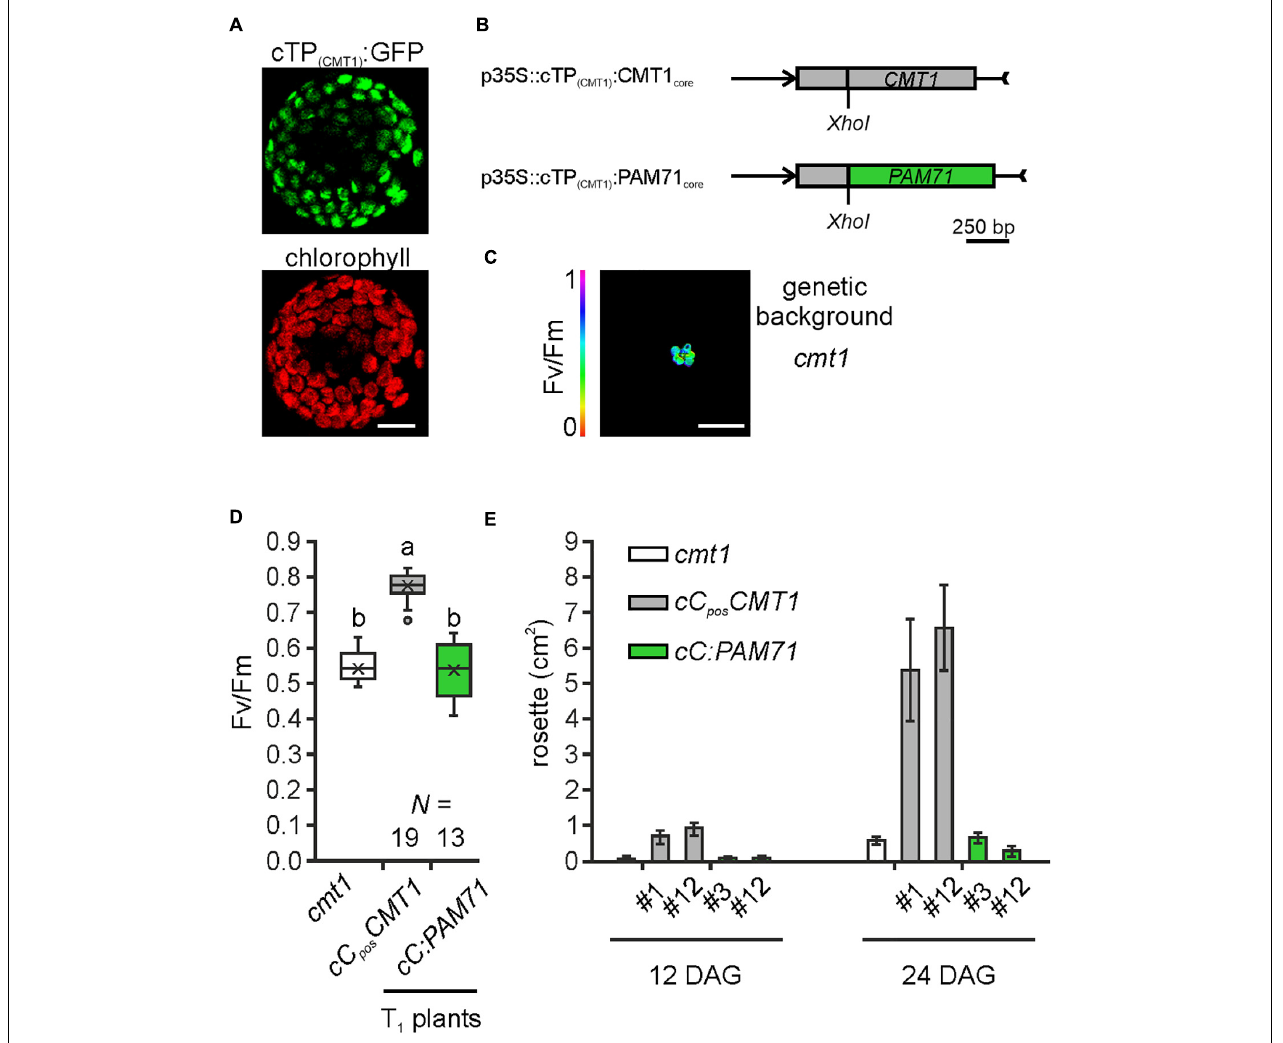
FIGURE 6 | Experimental setup for gene replacement assay and analysis of individual transgenic lines in the cmt1 genetic background. (A) Verification of the N-terminal CMT1 sequence as a chloroplast-targeting peptide. Nicotiana benthamiana leaves were infiltrated with the Agrobacterium strain containing p35S:cTP ( CMT 1 ) :GFP; protoplasts were isolated after 48 h and analyzed by confocal microscopy. Scale bar = 12.5 µ m. (B) Schematic depiction of the chimeric constructs used for transformation of cmt1. (C) The cmt1 mutant as genetic background. The maximum quantum yield of PSII (Fv/Fm) of a 4-week-old plant is shown. Scale bar = 1 cm. (D) Photosynthetic activity of BASTA resistant T 1 transgenic plants in comparison to cmt1 . The maximum quantum yield of PSII (Fv/Fm) of T 1 plants is depicted as box plots representing the range of values, the exclusive median and the mean, indicated as x. The number of independent plant lines is given (N). Outliers are indicated as dots. Different letters indicate statistical significance according to ANOVA ( p < 0.01, Tukey’s HSD test). (E) Quantification of growth phenotypes of the indicated genotypes. Leaf areas of selected transgenic lines in comparison to cmt1 were determined from photographs taken 12 days after germination (DAG) and 24 days after germination (DAG). Mean values ± SD ( n = 10) are